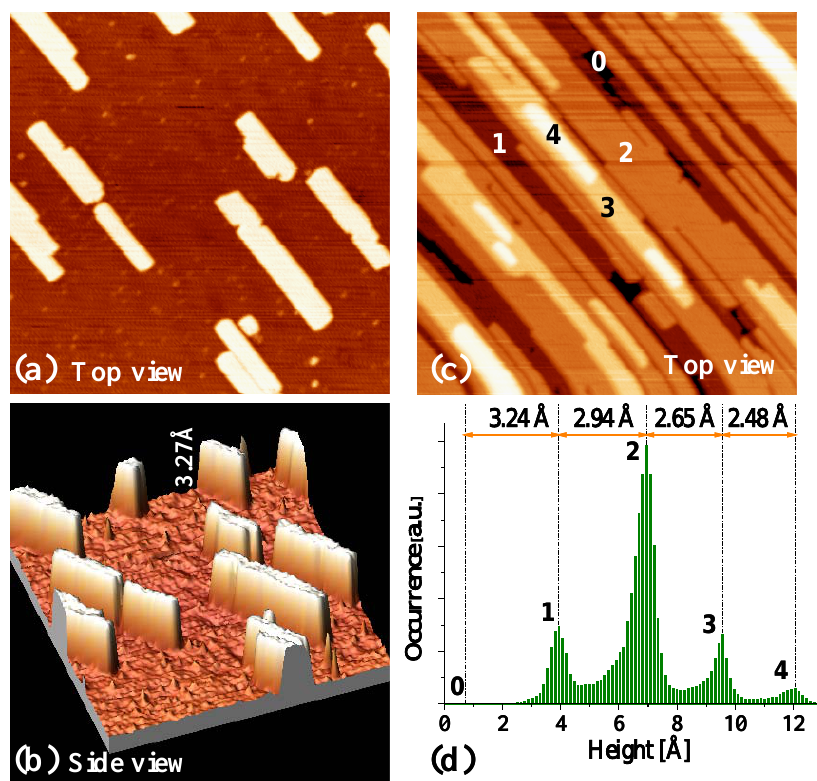
Figure 12. STM images (size: 100 × 100 nm 2 ) for Ag deposited on NiAl(110) at 200 K. Flux is 0.0066 ML/s. (a) Top view at Ag coverage of 0.3 ML. (b) A side view of (a). The measured island height is marked. (c) Top view at Ag coverage of 4.0 ML. The island (or film) height levels are labeled. (d) Pixel height histogram corresponding to (c). Here 0 is determined to be the height of the (completely covered) substrate from analysis of height histograms for a sequence of lower coverages. Adapted from [46] (Copyright American Physical Society